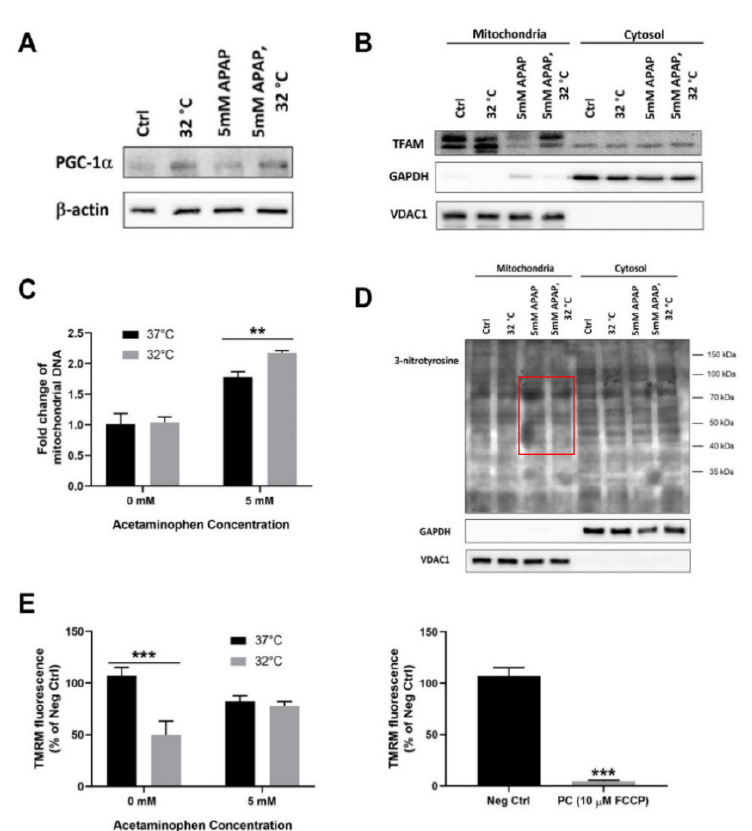
Figure 2. E ff ect of moderate hypothermia (32 ◦ C) on the extent of mitochondrial biogenesis in TAMH. Western blotting was performed to examine the protein expressions of ( A ) peroxisome proliferator-activated receptor gamma coactivator 1-alpha (PGC-1 α ) and ( B ) transcription factor A, mitochondrial (TFAM) in the mitochondrial and cytosolic fractions while ( C ) quantitative analysis with real time RT-PCR was carried out to determine the relative mitochondrial DNA levels. ( D ) The extent of mitochondrial dysfunction was also investigated based on the levels of 3-nitrotyrosine protein adducts, where distinct di ff erences were demarcated with the red box and ( E ) the changes in the mitochondrial membrane potential was determined based on the fluorescence intensity of tetramethylrhodamine methyl ester (TMRM); cells treated with 10 µ M carbonyl cyanide-p-trifluoromethoxyphenylhydrazone (FCCP) were used as positive control. glyceraldehyde-3-phosphate dehydrogenase (GAPDH) and voltage dependent anion channel 1 (VDAC1) were used as the housekeeping proteins for cytosolic and mitochondrial fractions, respectively, in western blots involving subcellular fractionation while β -actin was used as the housekeeping protein on western blots involving whole cell lysates. Data are presented as mean ± SD ( n = 3), where unpaired t-test was used to compare the e ff ect of hypothermia on TAMH against their respective controls treated with the same APAP dose. ** p < 0.01,*** p <